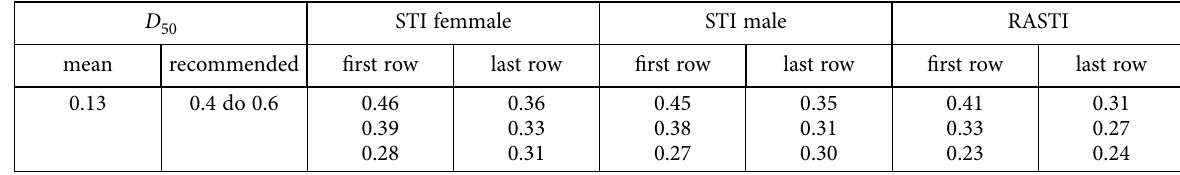
Table 3. Values of acoustic parameters D 50 , STI and RASTI obtained from in situ measurements along with recommended values D 50 STI